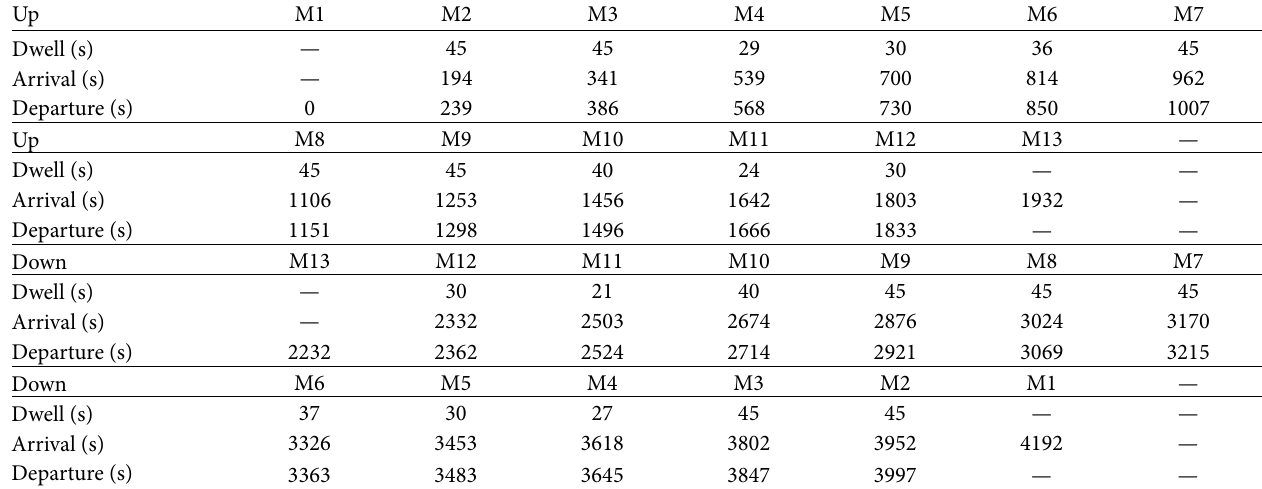
Table 11: The optimized timetable for the first train of the OEST.